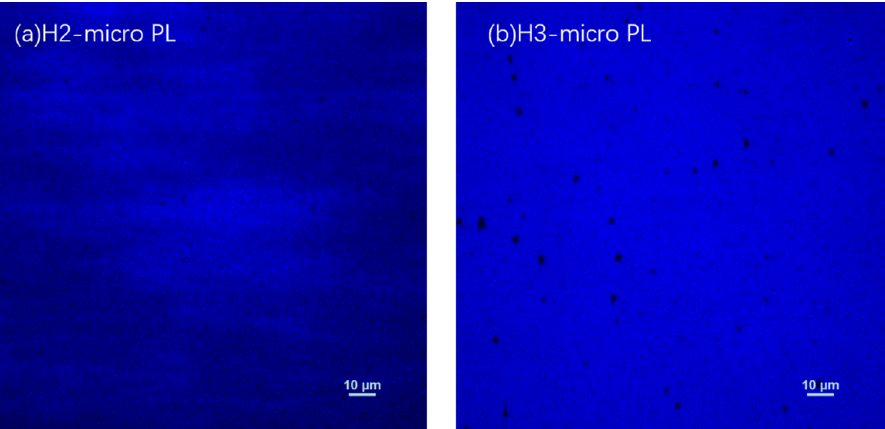
Figure 7. The micro-PL images of ( a ) sample H2 and ( b ) sample H3. The brightness of dots is proportional to the PL luminescence intensity at each spot.